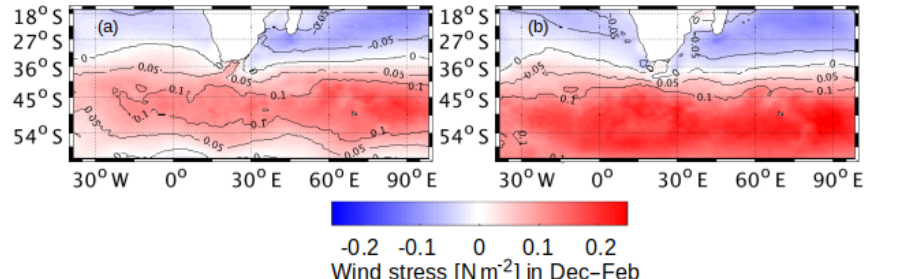
Figure 3. Temporal mean of the December–February wind stress (Nm − 2 ) for the periods 1964/1965 (a) and 2007/2008 (b) derived from the COREv2 data set. Contours and shading represent the same